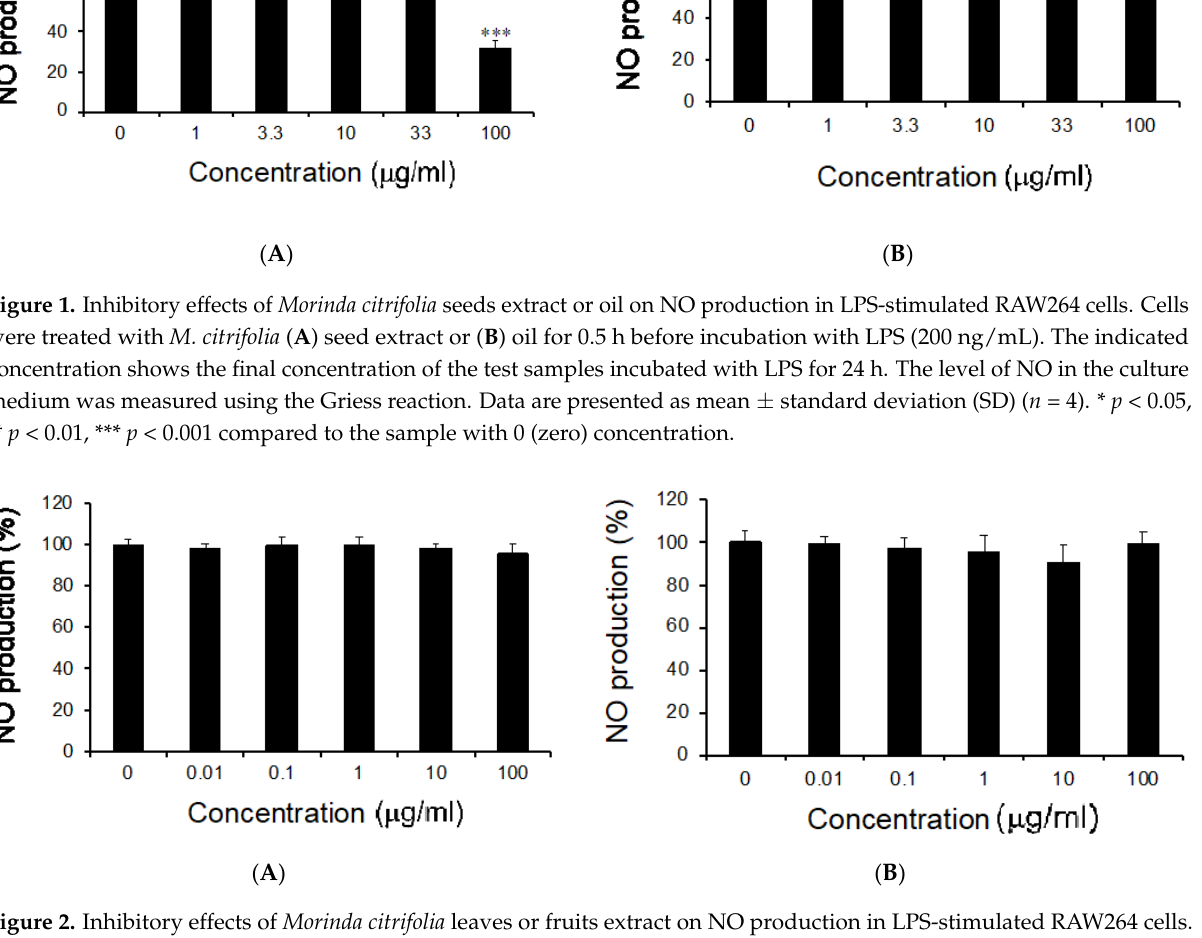
Figure 2 . Inhibitory effects of Morinda citrifolia leaves or fruits extract on NO production in LPS-stimulated RAW264 cells. Cells were treated with the extract of M. citrifolia ( A ) leaves or ( B ) fruit for 0.5 h before incubation with LPS (200 ng/mL). The indicated concentration shows the final concentration of the test samples incubated with LPS for 24 h. The level of NO in the culture medium was measured using the Griess reaction. Data are presented as mean ± SD ( n = 4).